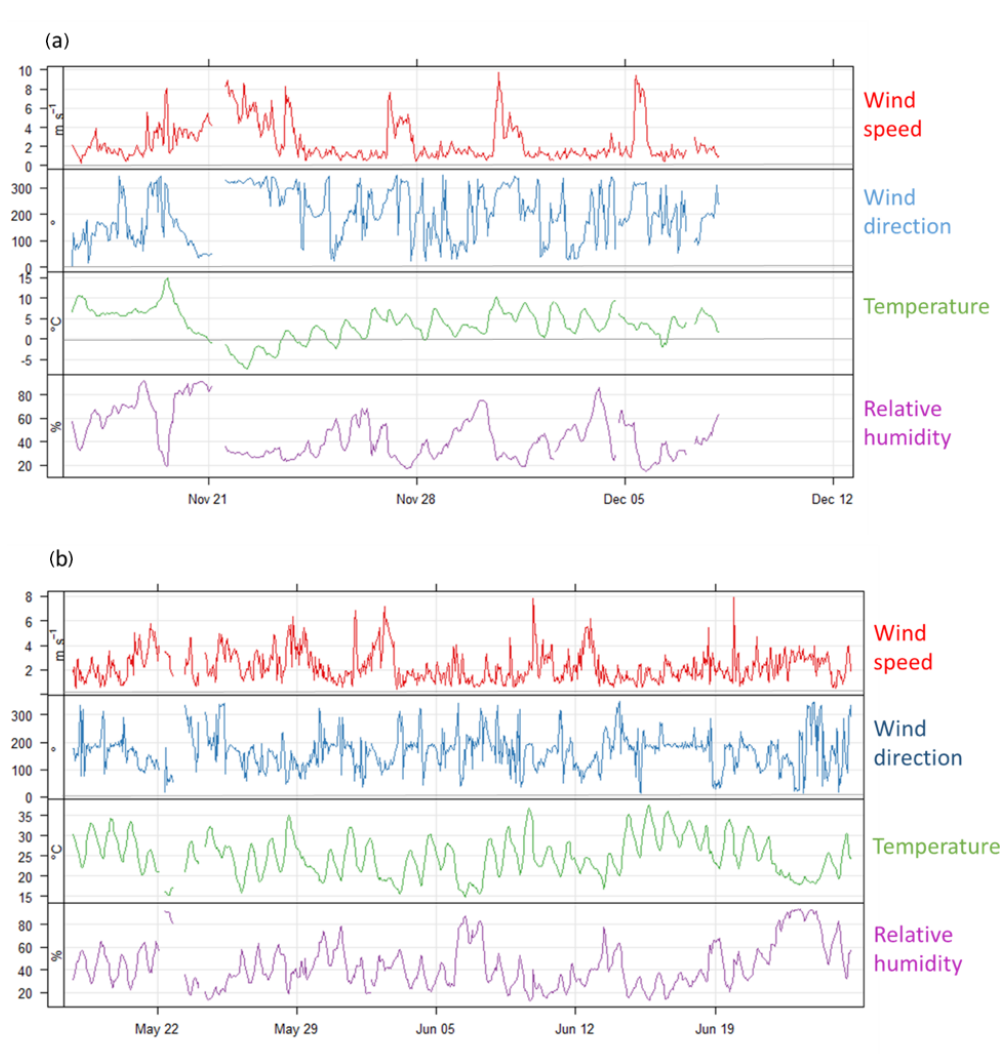
Figure 3. Summary of meteorological data in winter measurement campaign (a) and summer measurement campaign (b)